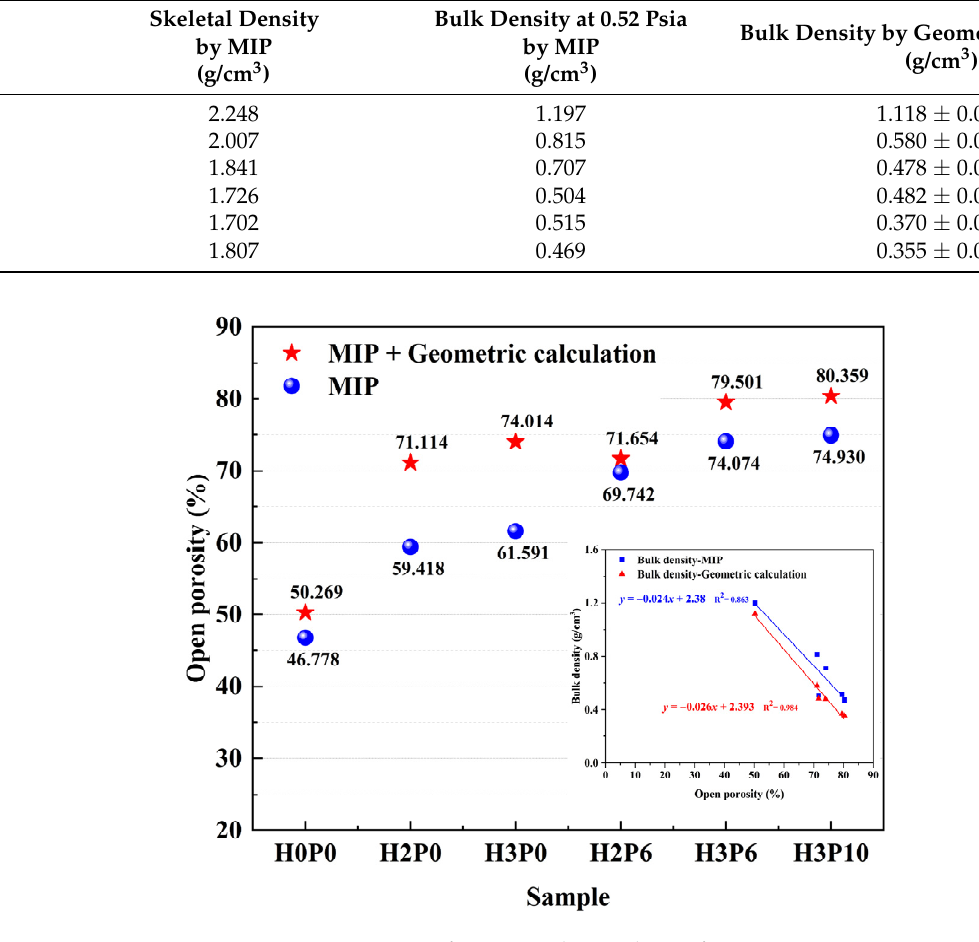
Figure 10. Open porosity of matrix and geopolymer foams.